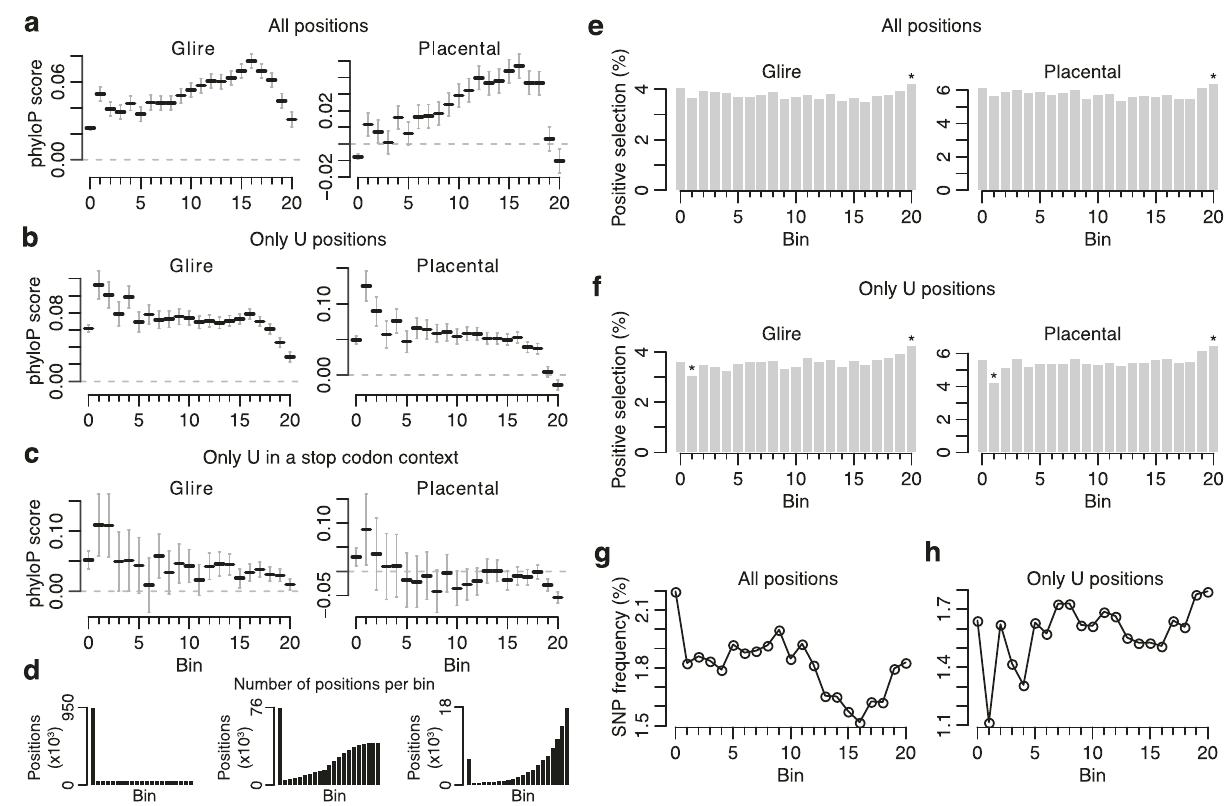
Fig. 5 Sequence conservation at mouse pachytene piRNA clusters. a phyloP conservation scores (in glires and placental mammals, respectively) at cluster positions binned by piRNA 5 ′ end de fi nition score. The number of cluster positions per bin is shown in ( d ). Horizontal lines represent the mean with a 95% con fi dence interval. b Same as ( a ), but only positions with a U nucleotide are shown. c Same as ( a ), but only positions with a U nucleotide in stop codon context are shown. d Overview of cluster positions per bin using all positions (left), only U positions (middle), or positions with U in a stop codon context (right). e Bar plots showing the percentage of positions per bin with a signi fi cant phyloP score (in glires and placental mammals, respectively) indicating positive selection. Asterisks mark bins that were signi fi cantly different from all bins ( p < 0.05; two-sided Z test). f Same as ( e ), but only positions with a U nucleotide are shown. g SNP frequency at cluster positions binned by piRNA 5 ′ end de fi nition score. A SNP was considered to be present at a certain position if it was listed in dbSNP. h Same as ( g ), but only positions with a U nucleotide are shown. Source data are provided as a Source Data fi